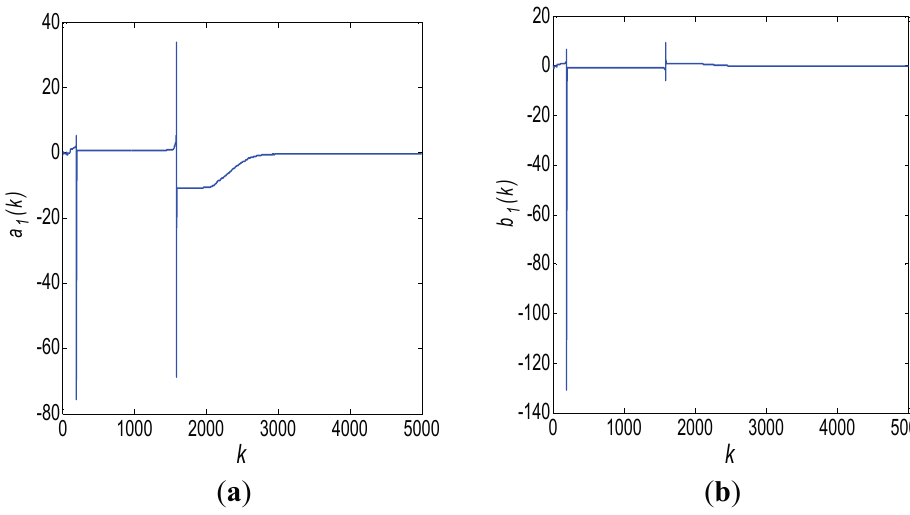
Figure 4. ARMA (1,1) modeling results using a robust Kalman filter: ( a ) a 1 estimate; ( b ) b 1